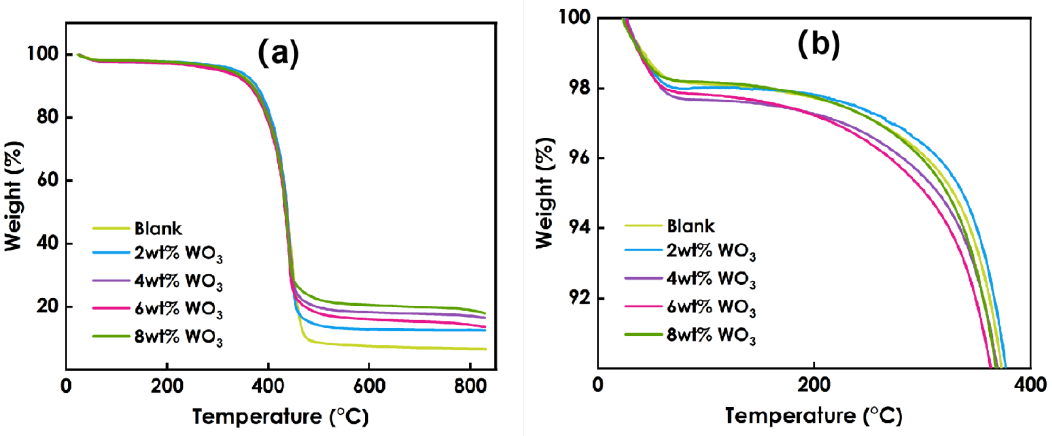
Figure 8. TG data of coatings prepared using different amounts of WO 3 :( a ) the temperature between 0 – 800°C, ( b ) the temperature between 0 – 400°C.